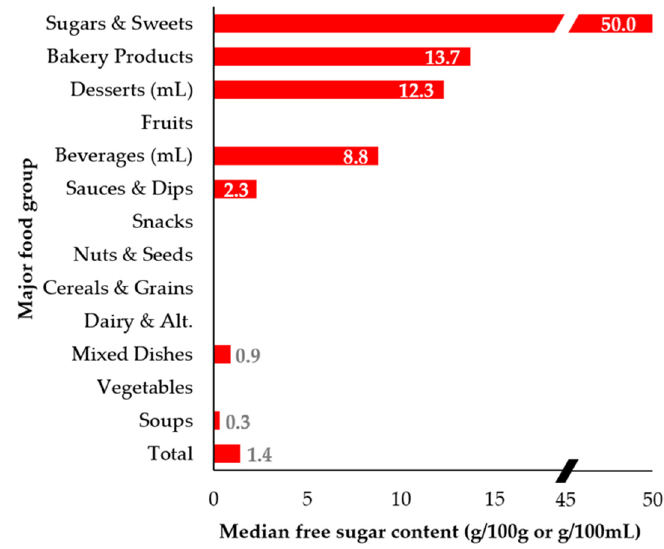
Figure 2. Median total sugar and free sugar content (g/100 g or g/100 mL) by major food group and overall ( n = 15,259): ( Top ) median total sugar content; and ( Bottom ) median free sugar content. Categories with 0 g/100 g or 100 mL median total sugar and free sugar (i.e., other foods and beverages; fats, oils, and vinegars; meat and alternatives; and fish and seafood) are not shown. ( ) denotes a break in the x-axis between 20 and 45 g/100 g. Table 2. Types of free sugar ingredients (FSI) identified in the FLIP 2013 database of Canadian prepackaged foods and beverages, by descending order of use ( n = 15,259).